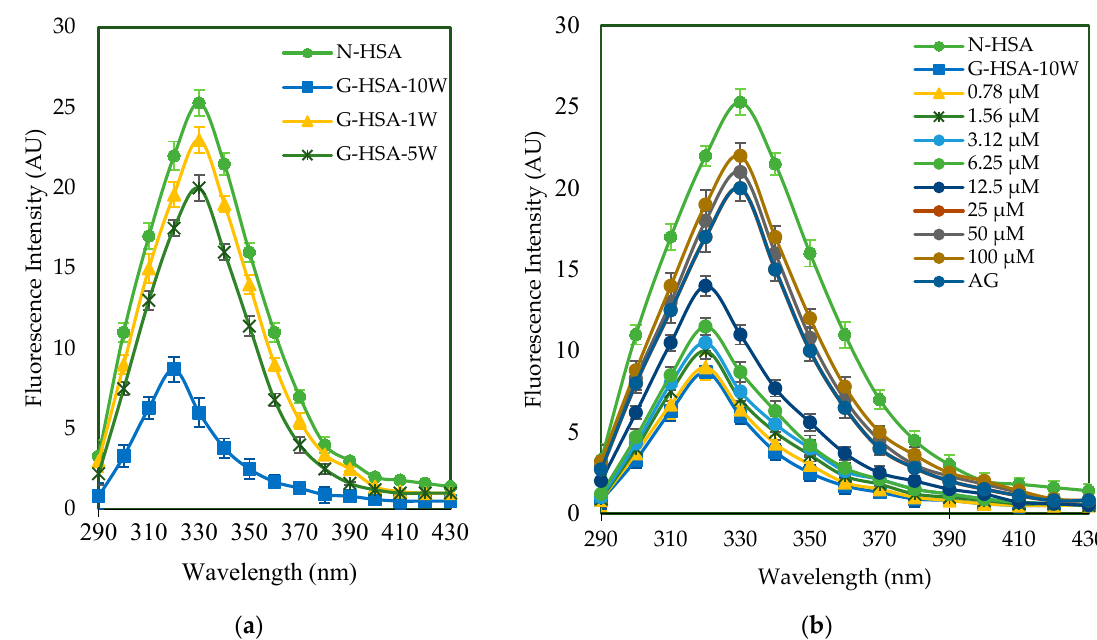
Figure 7. Tryptophan fluorescence emission spectra were estimated for N-HSA, G-HSA-1W, G-HSA-5W, and G-HSA-10W ( a ). Effect of garlic extract on the protein microenvironment structure alteration during glycation of HSA (10 weeks) with different concentrations (0.78–100 µg/mL) ( b ). All the samples were excited with a wavelength of 285 nm. Data is presented as mean ± SD values. t test was adopted for the comparison between N-HSA vs. G-HSA-1W, G-HSA-5W, and G-HSA-10W.